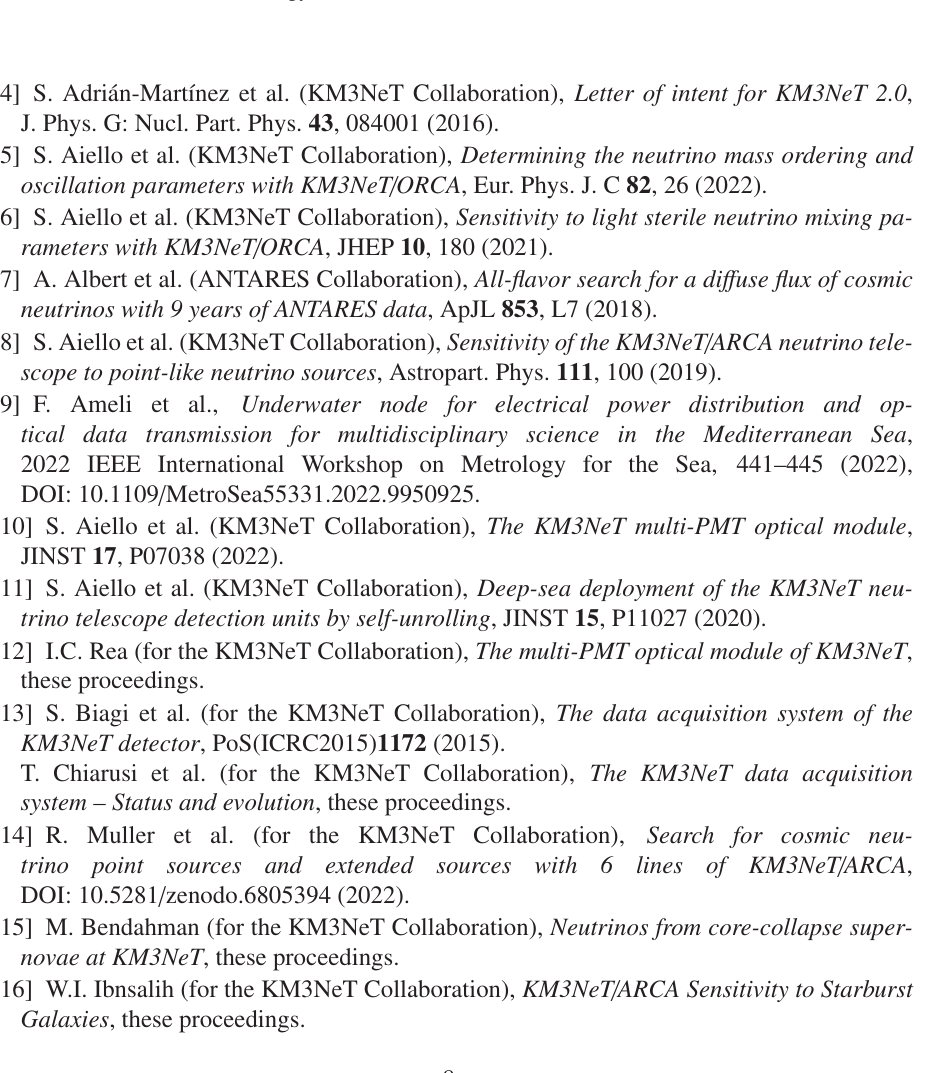
Figure 6. Left: Median angular resolution of the full ARCA detector as a function of the neutrino energy for track-like events. Shadowed areas represent the 50 and 90 percentile. The red line is the angle between the ν µ and the secondary µ . Right: Median angular resolution of the full ARCA detector as a function of the neutrino energy for shower-like